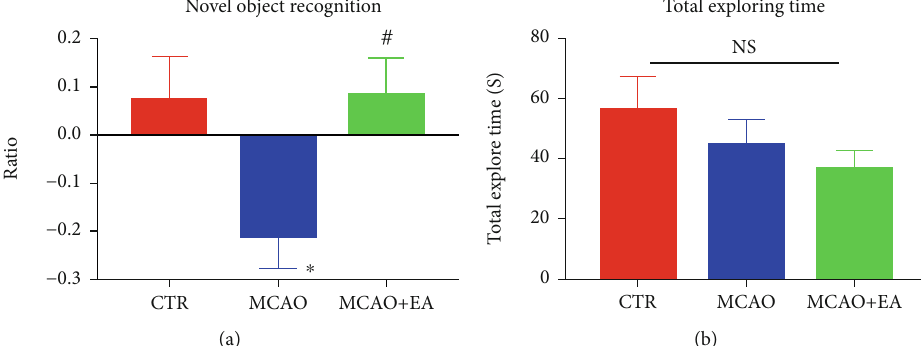
Figure 4: E ff ects of the MCAO and EA in the novel object recognition test. The discrimination index of the novel object (a). Negative ratio means the rats preferred to explore the familiar object rather than the novel object. Total exploring time in test phases (b). Data are expressed as mean ± SEM , where ∗ p < 0 : 05 , compared to the control group, and # p < 0 : 05 compared to the MCAO group ( n = 10 each group). NS: no signi fi cance; CTR: control; MCAO: middle cerebral artery occlusion; EA: